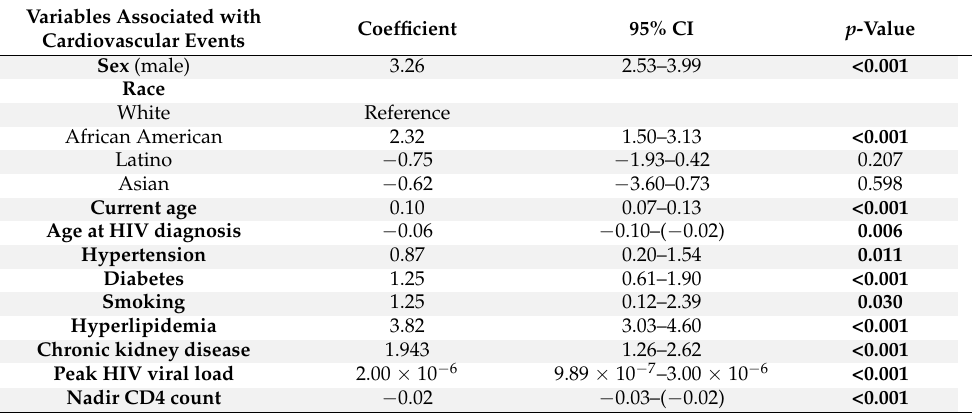
Table 2. Multivariable logistic regression model of statistically significant variables used to predict cardiovascular events in the development cohort (P model ≤ 0.0001).